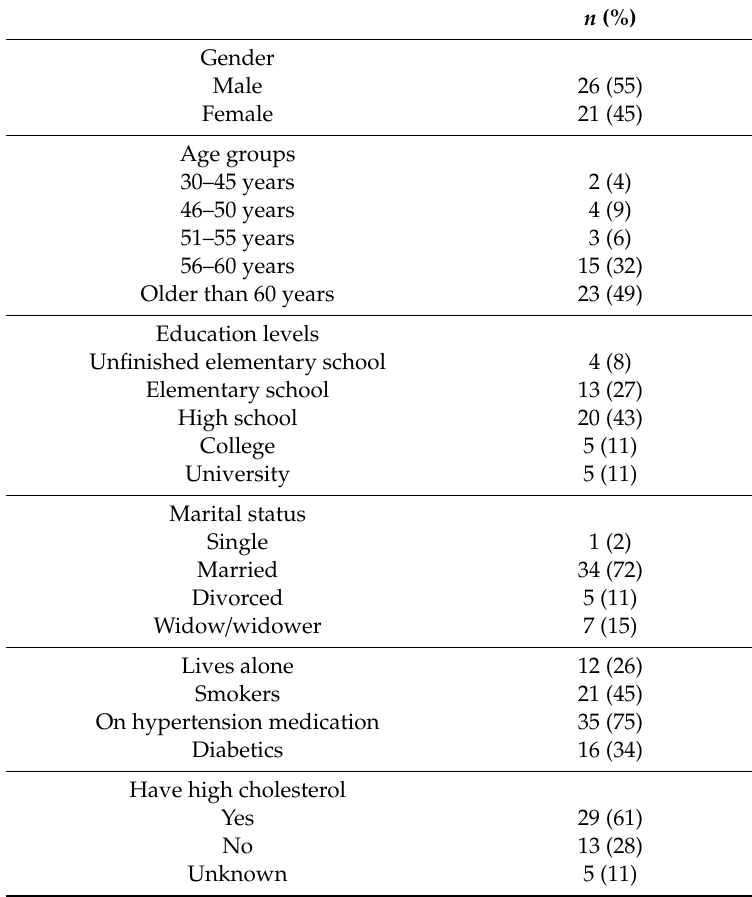
Table 1. Basic characteristics of the participants.